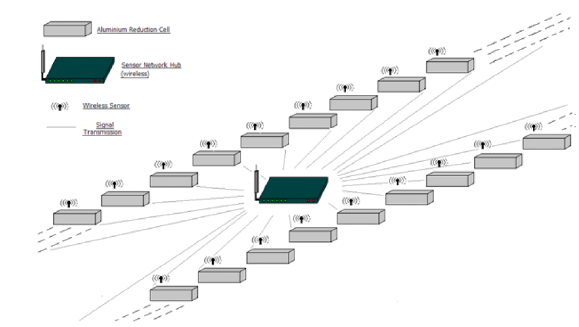
Figure 2: Sensor Networking in Light metal Industries, involving innovative usage of existing and new sensors. Graphic by PhD student Yan Ru.